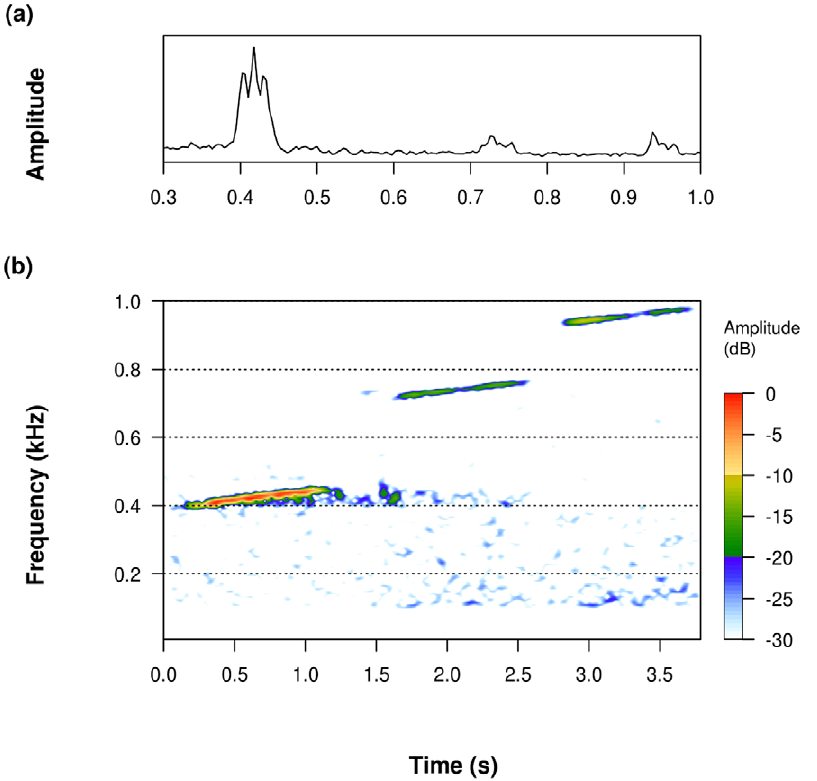
Figure 2. Characteristics of OAWRS signals recorded on MARUs deployed in the Stellwagen Bank National Marine Sanctuary. (a) Mean frequency spectrum, showing local peaks at center frequencies (approx. 415, 735, 950 Hz) of recorded OAWRS FM pulses. (b) Spectrogram (FFT: 512, Hanning window, 75% overlap) of the same pulses as shown in (a). Time interval between successive signals was changed for display purposes; dB scale is